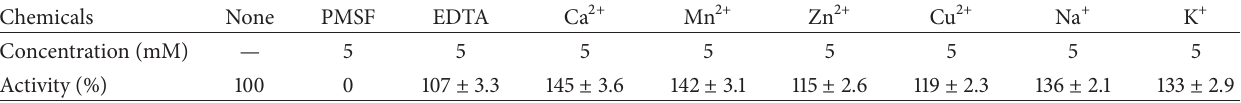
Table 3: Influences of the activity of the crude protease by various metal ions and enzyme inhibitors.